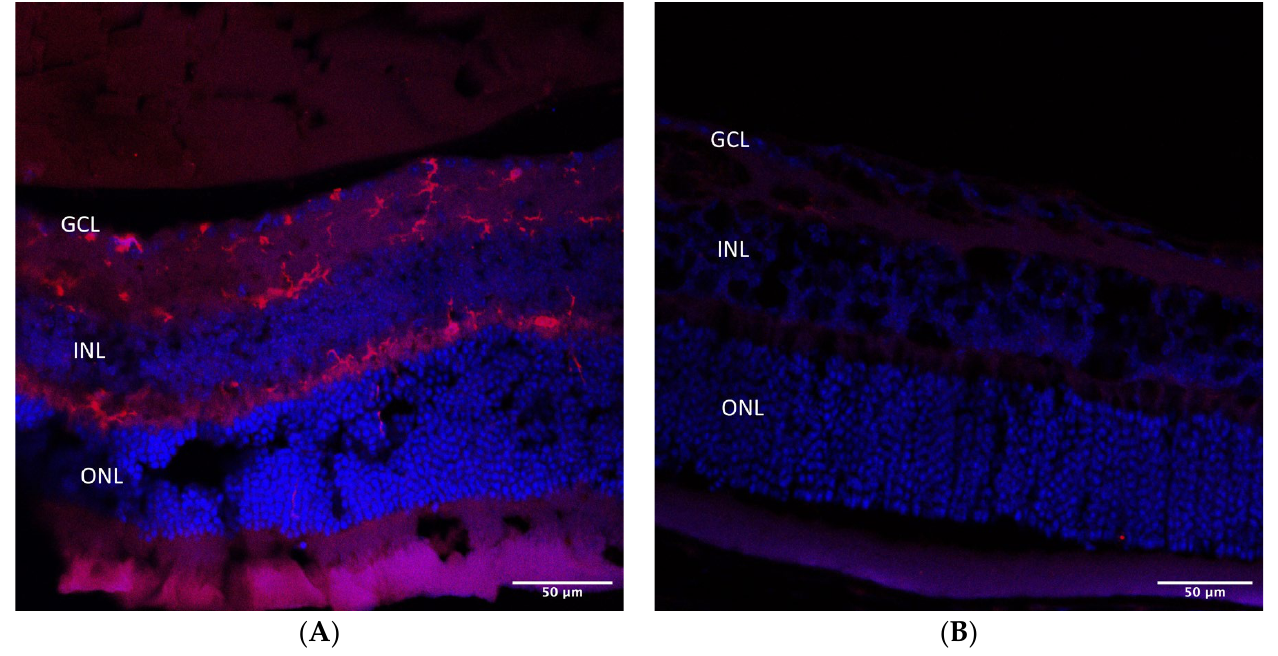
Figure 8. Iba1 staining. ( A ) Iba1 immunohistochemical staining in AZ-treated eyes of WT mice. Microglia activation is evident in the GCL and INL (red). ( B ) Iba1 immunohistochemical staining in control eyes. No microglia activation is noted. Iba1, red; DAPI, blue. AZ, azithromycin; WT, wild type; GCL, ganglion cell layer; INL, inner nuclear layer.